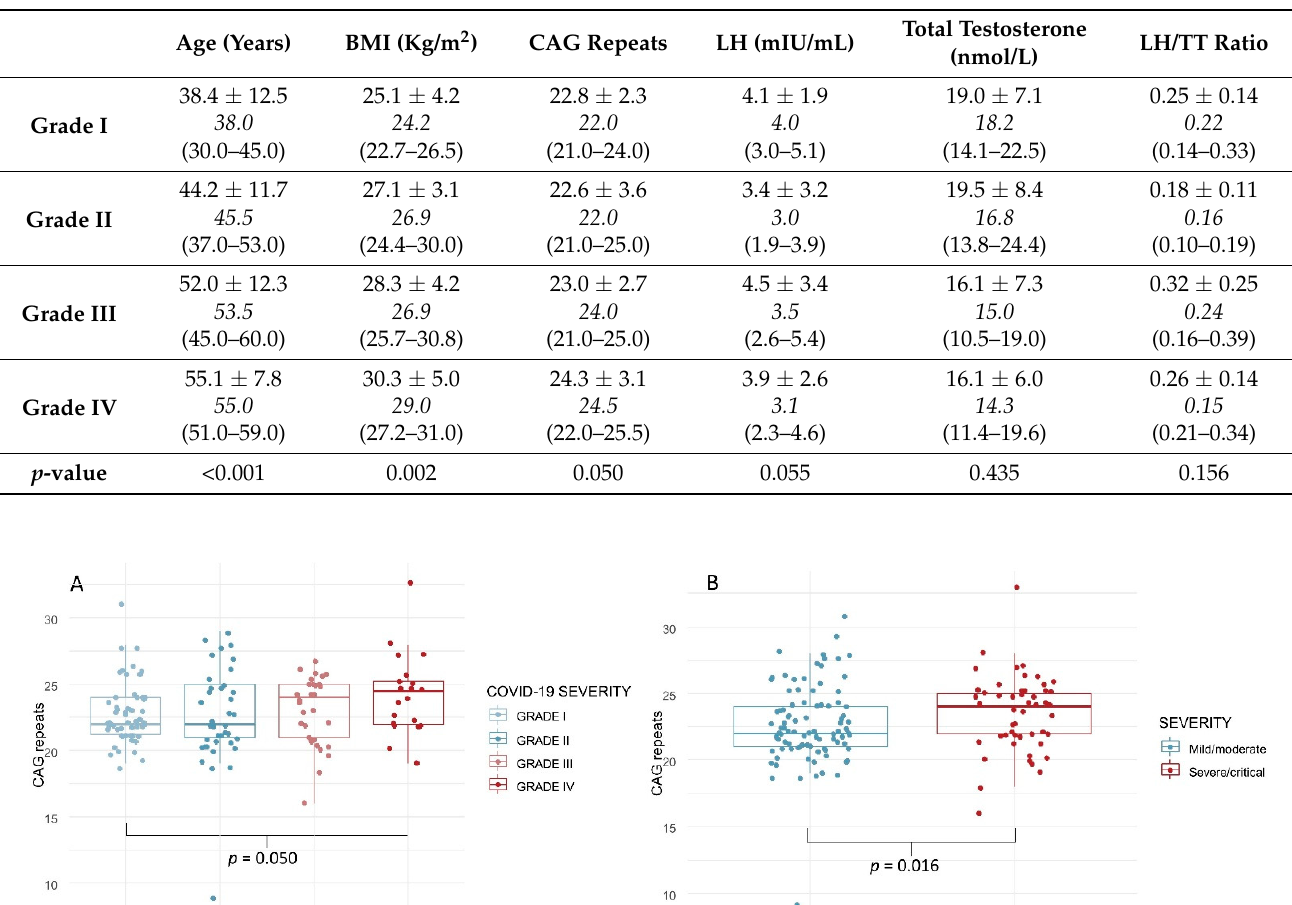
Table 1. Mean ± standard deviations, median (in italics) and 25th–75th percentile (in brackets) of relevant variables stratified by COVID-19 severity.